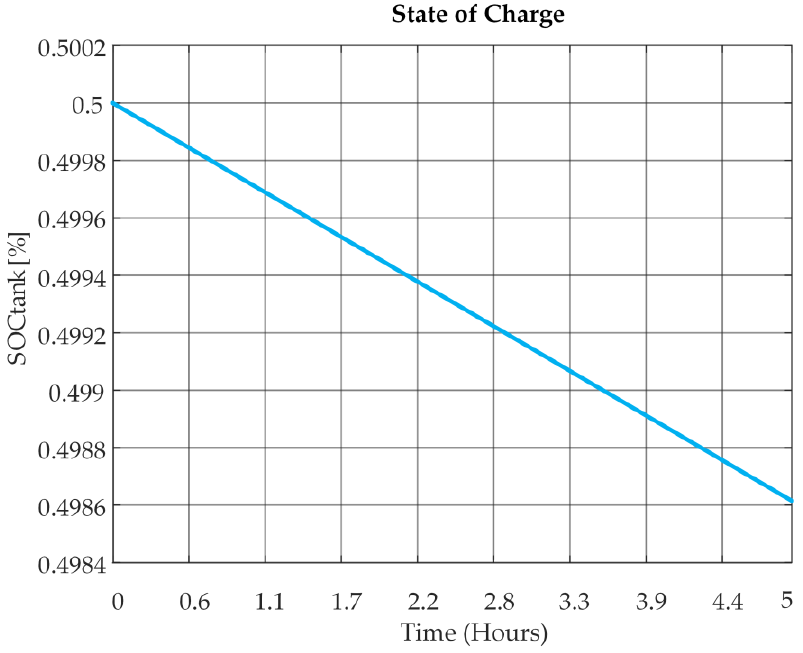
Figure 3. Self-discharging of tank electrolyte under stack idling condition with pump operation.